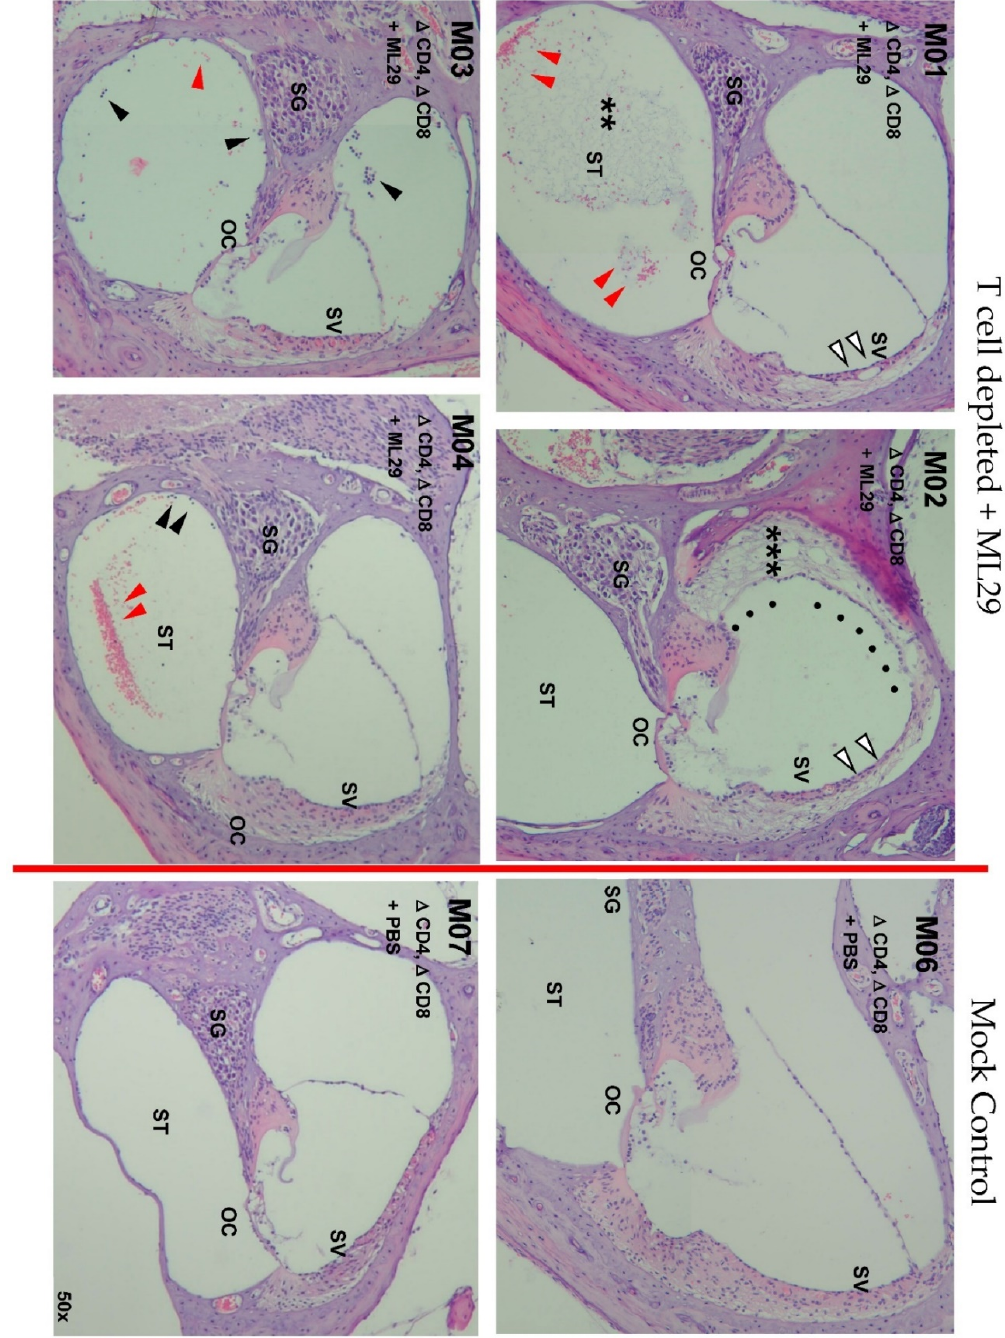
Figure 4. Damage within the inner ear occurs in a CD4/CD8 T cell-independent mechanism. Representative images of cross sections of the apical-middle turn of the cochlear duct are shown. PBS-inoculated mice have normal histology (M06 and M07). In all CD4/CD8 T cell-depleted, ML29-inoculated mice, the cochlear nerves remained mostly intact, although the nerves were surrounded by hemorrhage in many samples. Mild vacuolization is seen within the spiral ganglion (SG). Major thinning of the stria vascularis (SV) is seen (white arrowheads). The scala tympani (ST) features hemorrhage (red arrowheads) and white blood cell infiltration (black arrowheads). M01 presents with mild fibrous degeneration (**) within the ST, suggestive of inflammation. M02 presents with significant hydrops in the scala media as shown by the bowing of the Reissner’s membrane (black dots) and fibrous degeneration in within the perilymph in the scala vestibuli (***), indicative of severe inflammation. Minimal damage was seen in the hair cells and the organ of Corti